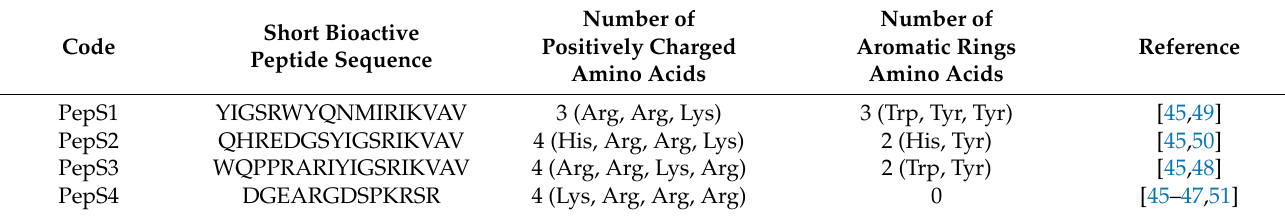
Table 1. Characteristics of designed peptide